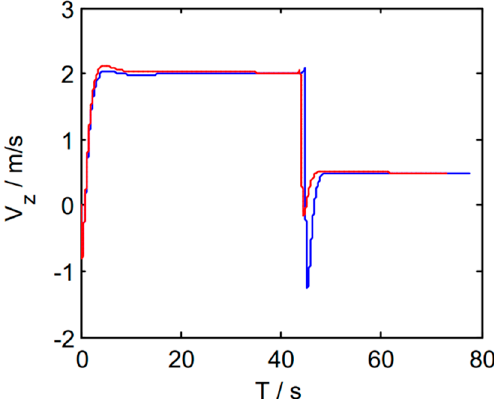
Figure 16. Landing speed in headwind conditions.